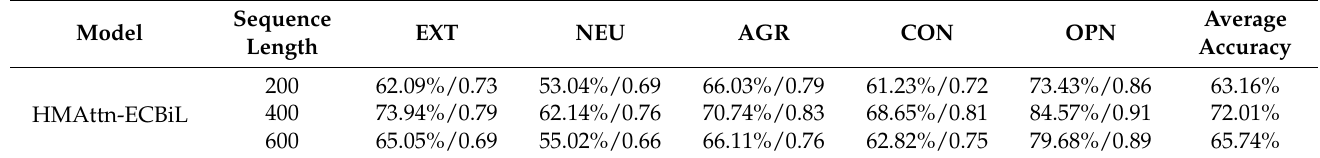
Table 3. Classification accuracy and F1-score comparison of fusion features extracted from different length sequences. Model